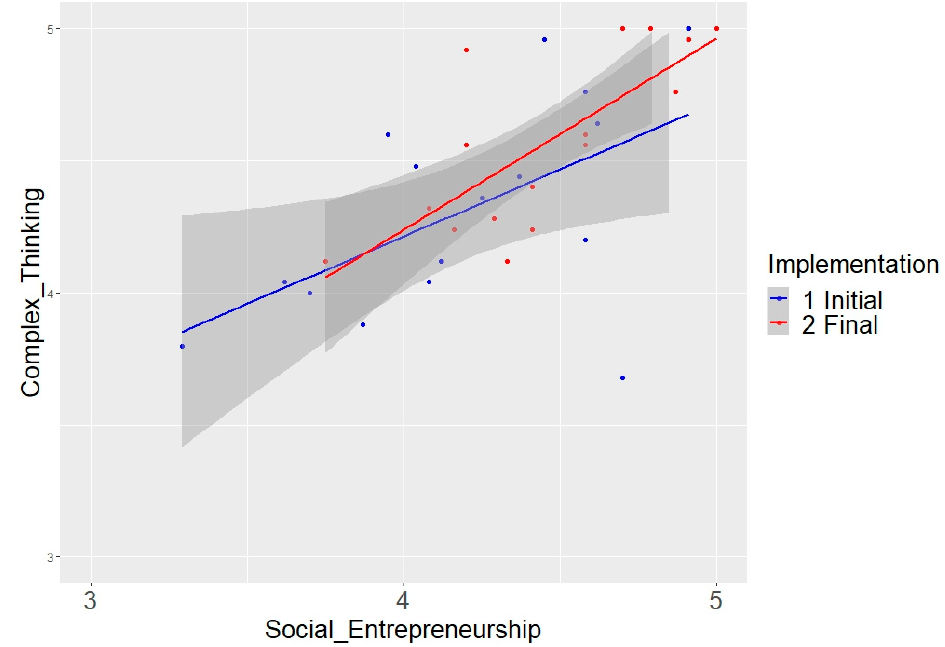
Figure 5. Correlation results of social entrepreneurship and complex thinking competencies.